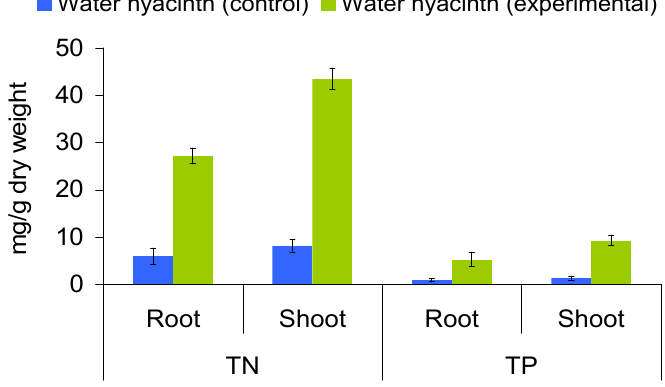
Figure 5. Nutrients (N & P) content in plant tissues before and after treatment by the Bio-hedge system ( n =